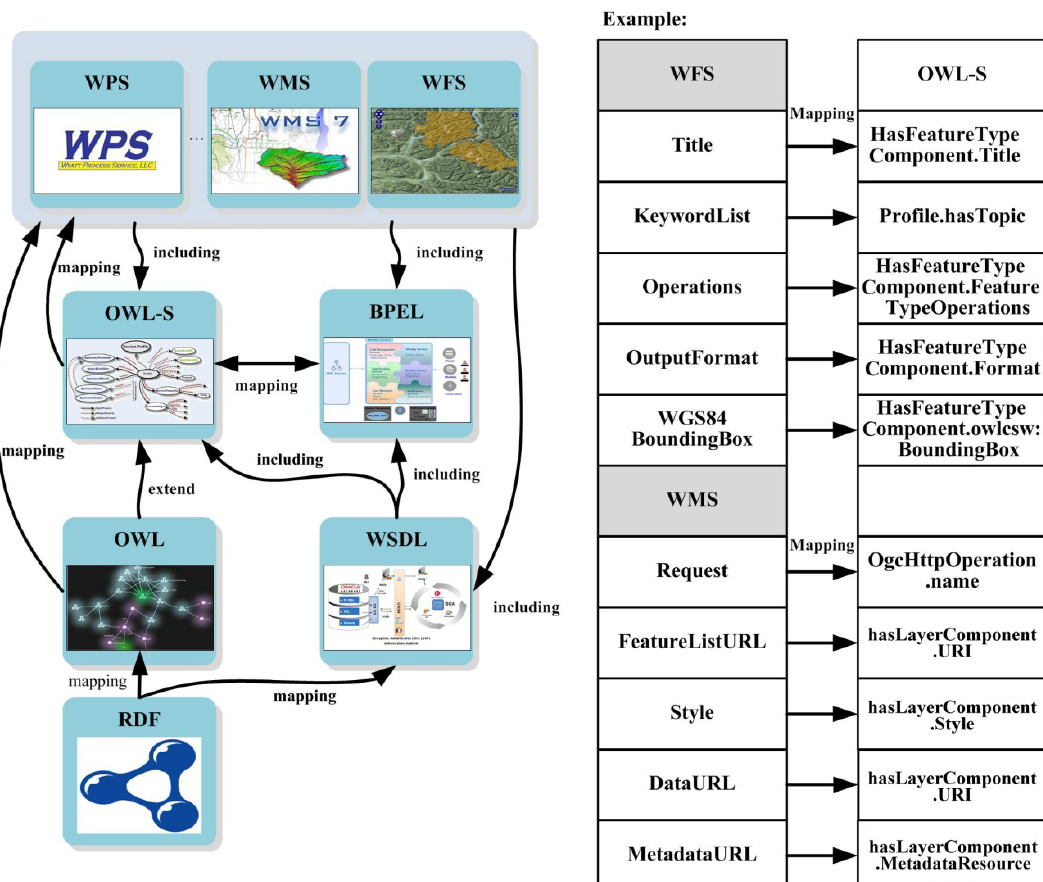
Figure 6. The relationships among the